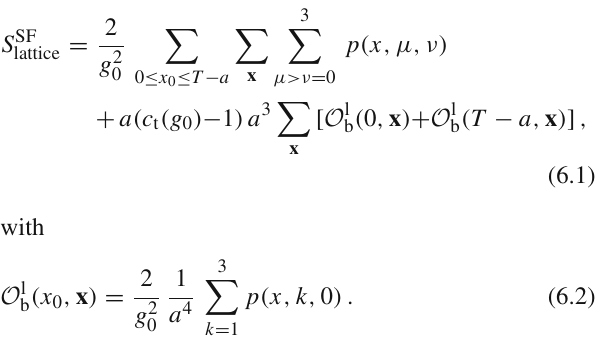
( a )/ P Fig. 4 Leading order discretization errors, (cid:4) P F of the static F ( 1 / r )/( 4 π) = 0 . 2, and force, see the text. We use α( 1 / r ) = ¯ g 2 lat = 0, K ( 0 ) ¯ c ( 0 ) = − 3 / 4, corresponding to the Wilson plaquette K ( 0 ) 1 2 2 action and the force along a lattice axes. The dotted line represents fixed order perturbation theory, the full line the remainder (on top of fixed order) predicted by SymEFT, and the dashed line shows a rough approximation, linear in a 2 , to that